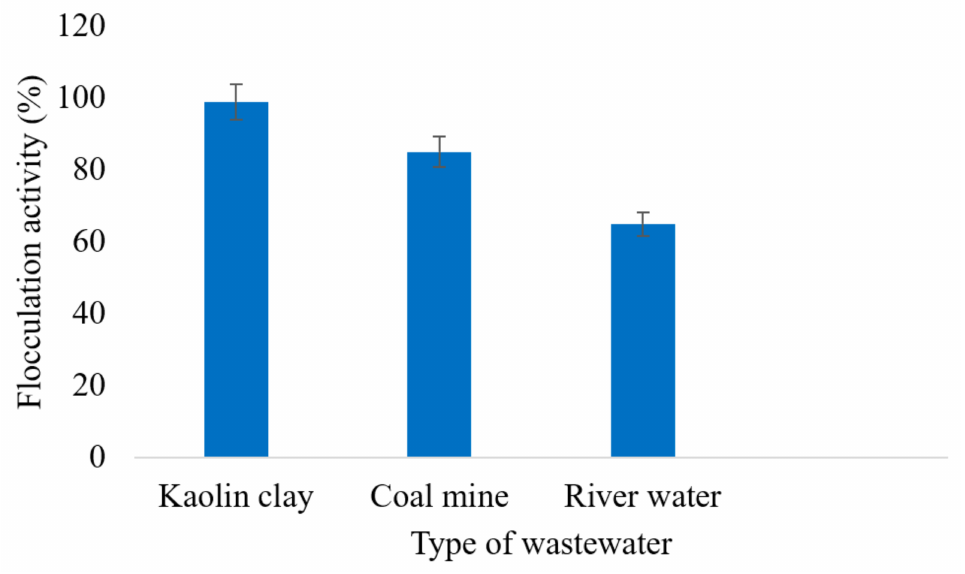
Figure 7. Effectiveness of FeCu nanoparticles in flocculating different water